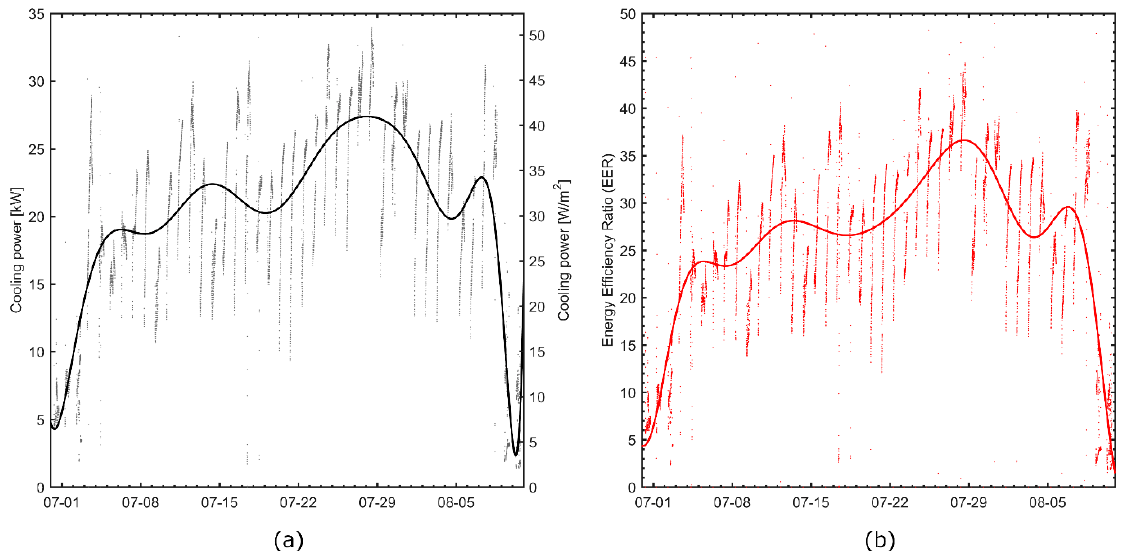
Figure 7. ( a ) Measured cooling power and ( b ) energy efficiency ratios (SEER) during the test (right). Raw data are shown as points while fitted, polynomial trends are drawn with full lines.